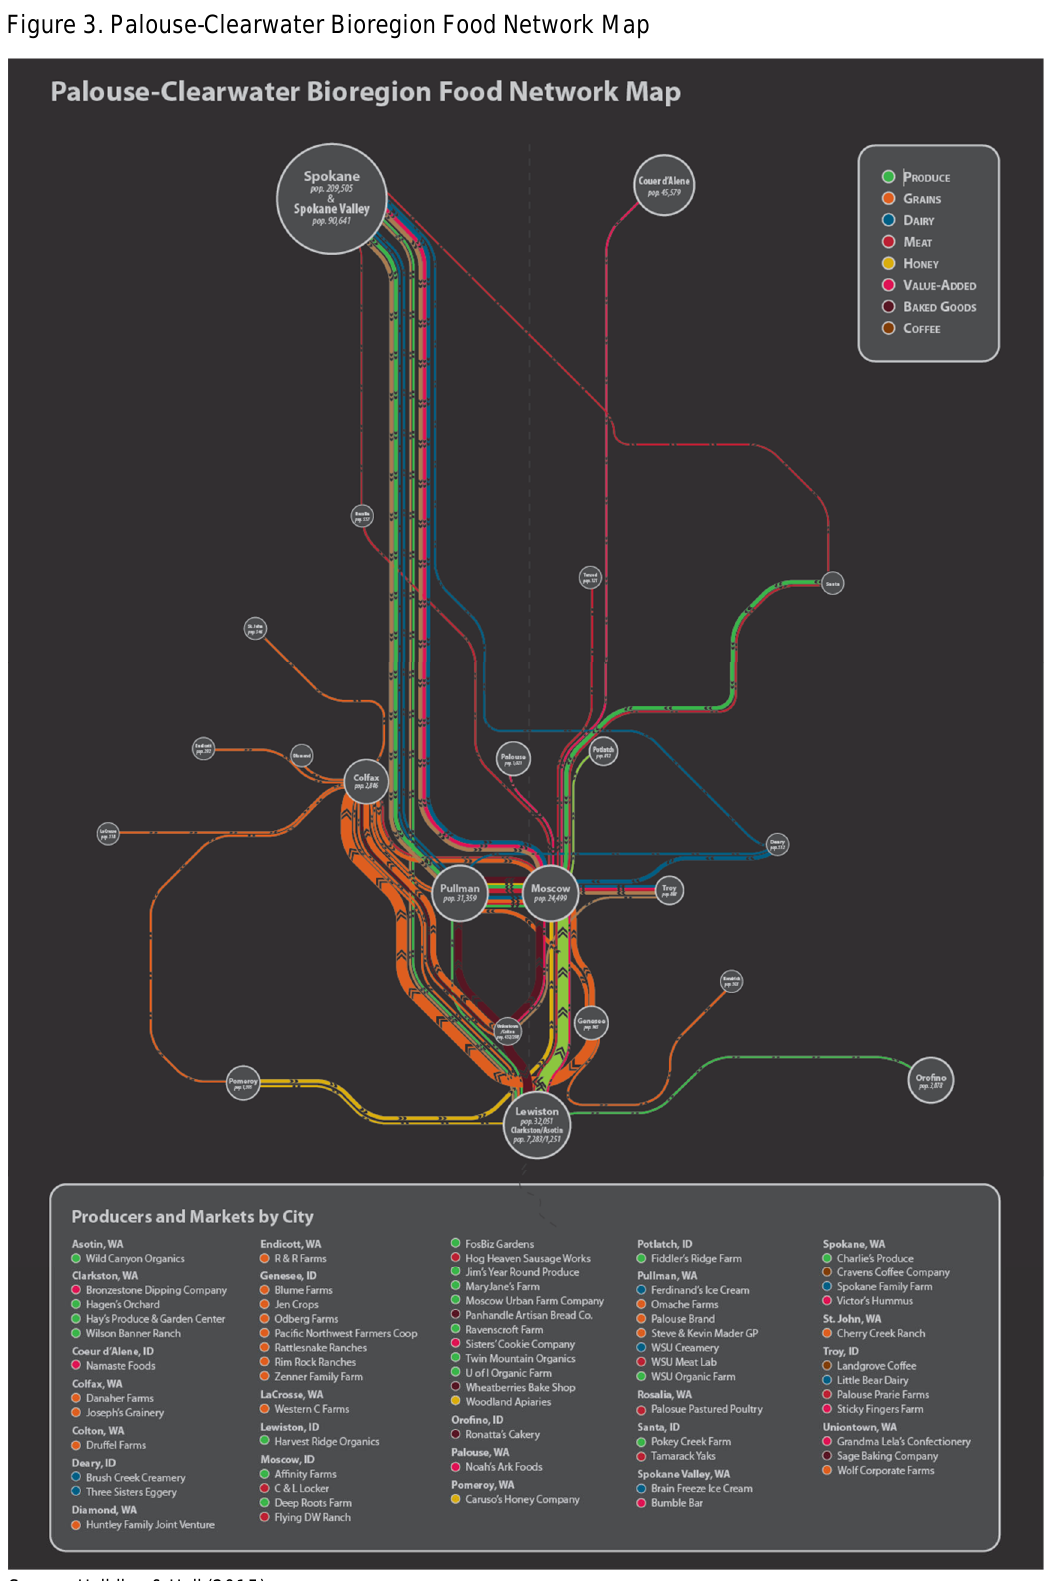
Figure 3. Palouse-Clearwater Bioregion Food Network